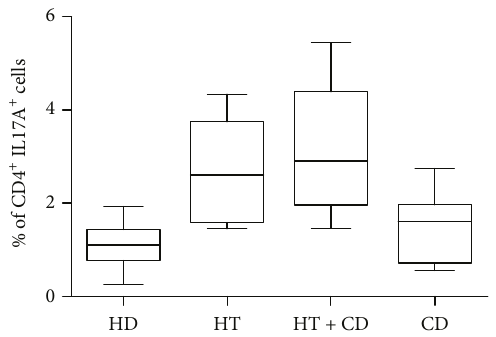
Figure 1: Th17. Percentage of Th17 cells (CD4 +IL17A+) in healthy donors (HD), in patients with Hashimoto thyroiditis (HT), in patients with Hashimoto thyroiditis plus celiac disease (HT+CD), and in patients with celiac disease (CD). Box plots indicate median, interquartile range (box), and minimum and maximum values (whiskers). Nonparametric Kruskal-Wallis test p = 0 0011 . Dunn posttest: HD vs HT p < 0 05 ; HD vs HT +CD p < 0 01 ; HT +CD vs CD p < 0 05 .